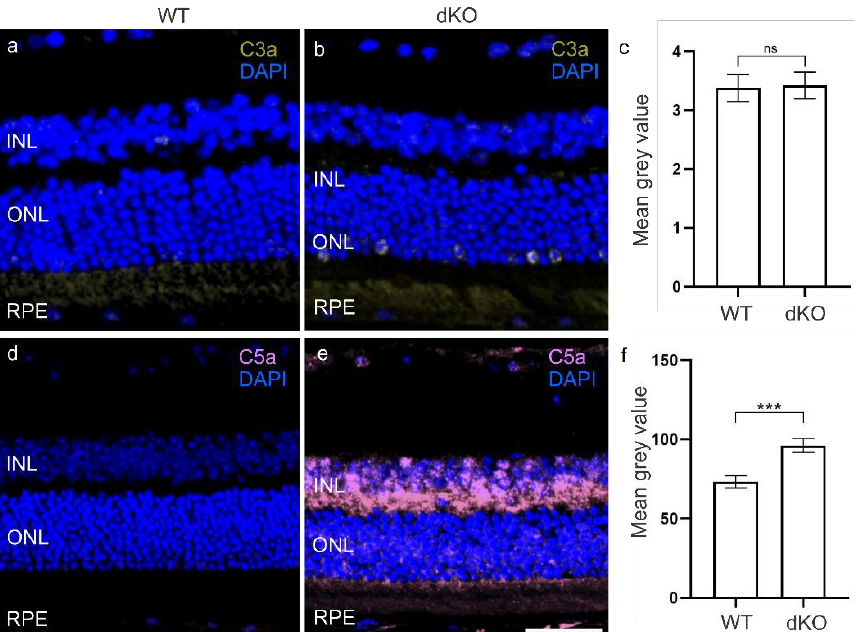
Figure 3. There was no statistical difference in the amounts of the complement component C3a in dKO ( b ) and WT ( a ) retina, p = 0.93 ( c ). In contrast, C5a levels were significantly increased in dKO ( e ) by ~30%, *** p = 0.0002 ( f ) compared to WT retina ( d ). Scale = 20 µm. ns — not significant.